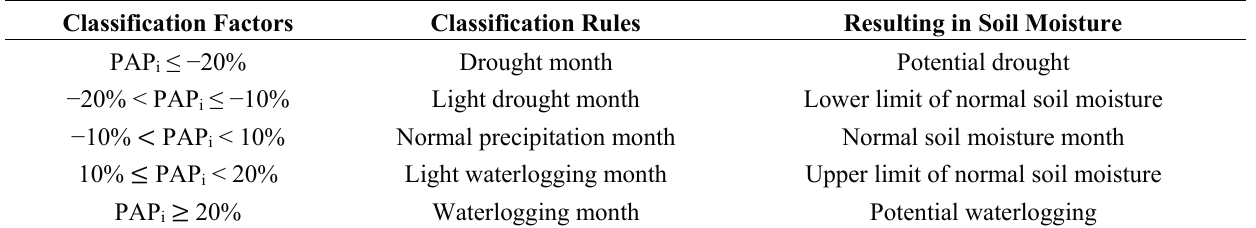
Table 1. Rules for classifying different months with different soil moisture